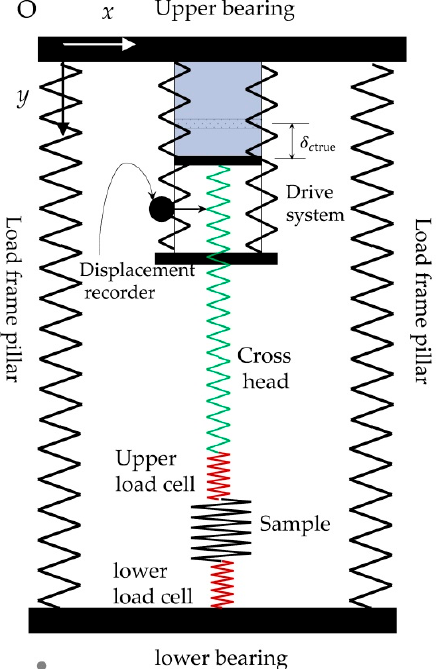
Figure A1. A simplified linear spring model of compression test system.